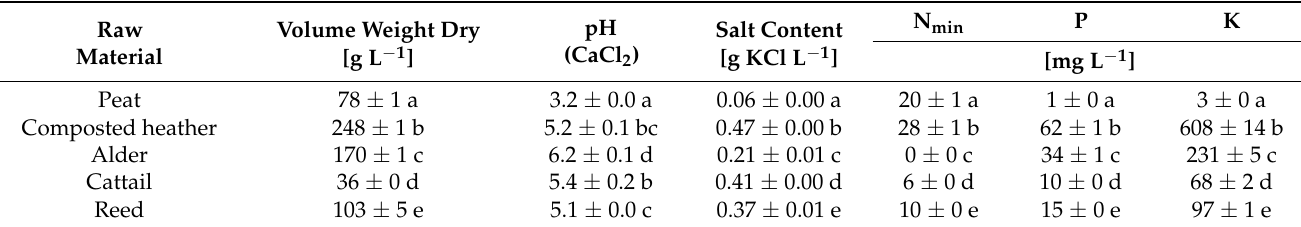
Table 3. Basic parameters of the processed materials in stage 1. n = 3, variance analysis: Kruskal–Wallis, post hoc test: pairwise t test, p < 0.05. Different letters indicate significant differences among raw materials.